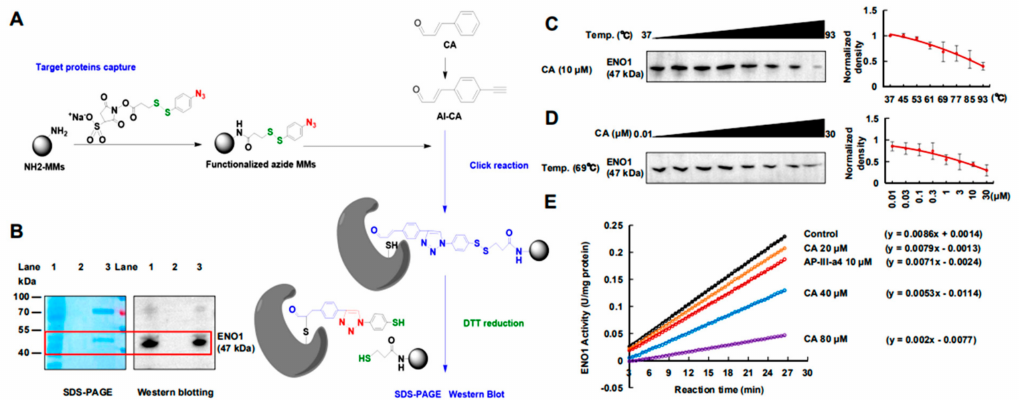
Figure 2. CA targeted ENO1 in A375 cells and changed its activity. ( A ) The modification process of AL-CA-MMs and the schematic diagram for target protein capture and release. ( B ) E ffi ciency evaluation of magnetic capture by SDS-PAGE. Lane 1 shows the A375 lysate as a loading control; Lane 2 shows the lysate captured only by the azide-modified MMs as a negative control; Lane 3 shows the lysate captured by AL-CA-MMs. Coomassie bright blue staining is shown in the left image, and the right image shows the ENO1 detected by Western blotting. ( C ) CA treatment (10 µ M) decreased the thermal stability of ENO1 in cell lysates measured by the temperature-dependent Cellular thermal shift assay (CETSA) ( n = 3). ( D ) CA treatment decreased the thermal stability of ENO1 in cell lysates measured by the concentration-dependent CETSA at 69 ◦ C ( n = 3). ( E ) CA inhibited the activity of ENO1. Cells were exposed to CA (0, 20, 40, or 80 µ M) or a positive ENO1 inhibitor, AP-III-a4 (10 µ M) for 0.5 h, and then the e ff ect on the activity of ENO1 in lysates was determined ( n = 3). CETSA indicated that the covalent binding changed the stability of the protein of ENO1 in a temperature- and dose-response manner (Figure 2C,D). The silenced ENO1 a ff ected the glycolytic process of 2-phospho-D-glycerate (2PG) to phosphoenolpyruvate (PEP), which was detected using an ENO1 Human Activity Assay Kit (ab117994, Abcam, (Cambridge, MA, USA), (Figure 2E). Hence, ENO1 was suggested as a potential antimelanoma target of